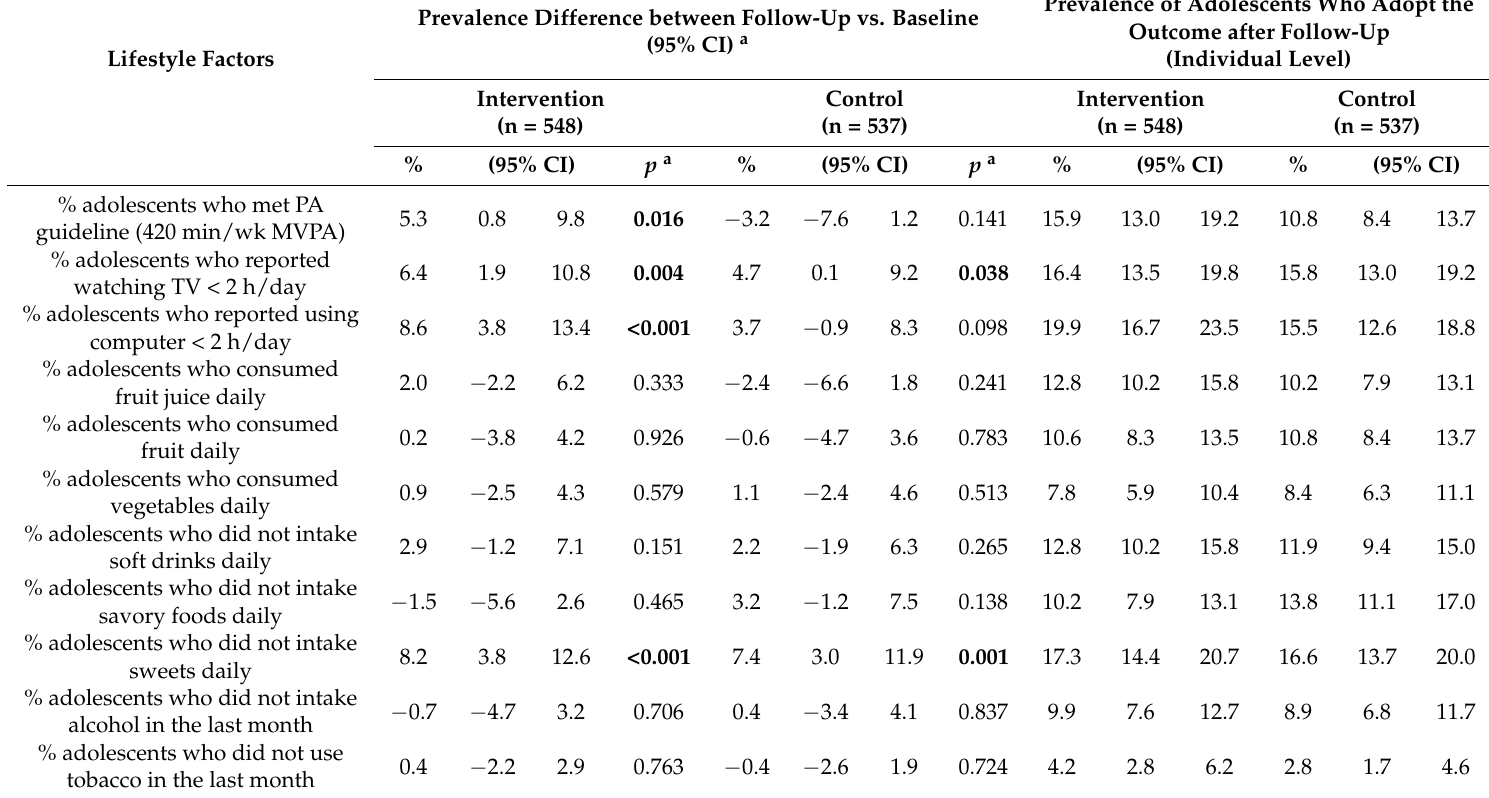
Table 3. Effect of the Fortaleça sua Sa ú de Program on Lifestyle Factors among Brazilian Adolescents from Low-HDI Areas, 2014. Prevalence Difference between Follow-Up vs. Lifestyle Factors